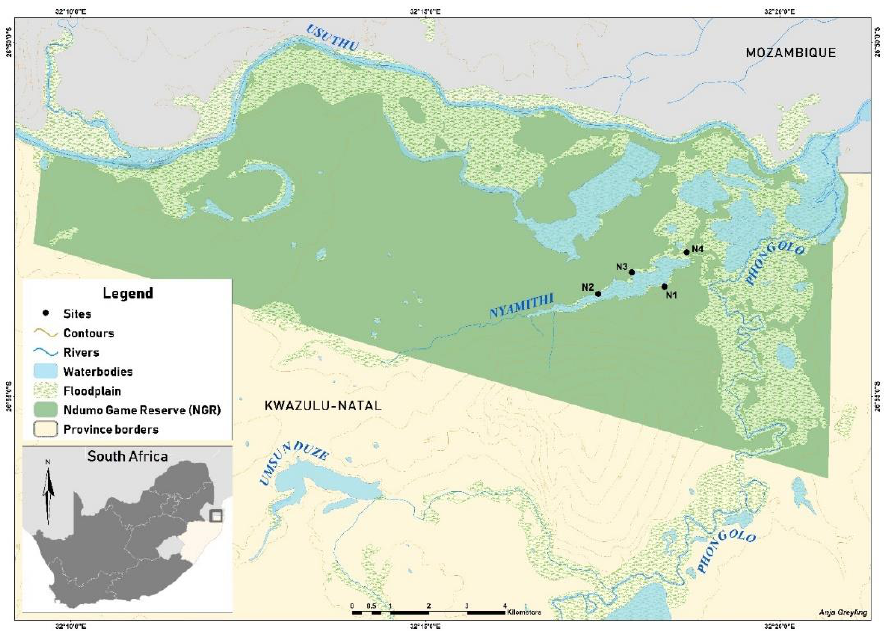
Figure 1. Map of Ndumo Game Reserve (NGR) and surrounding region indicating the sampling areas along the shoreline of Lake Nyamithi (N1 – N4). N – Nyamithi.